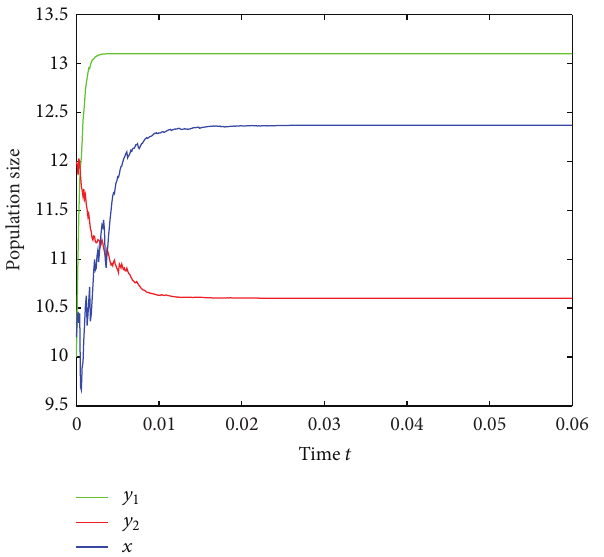
Figure 4: The solution of the stochastic model (4) with the same parameters as in Figure